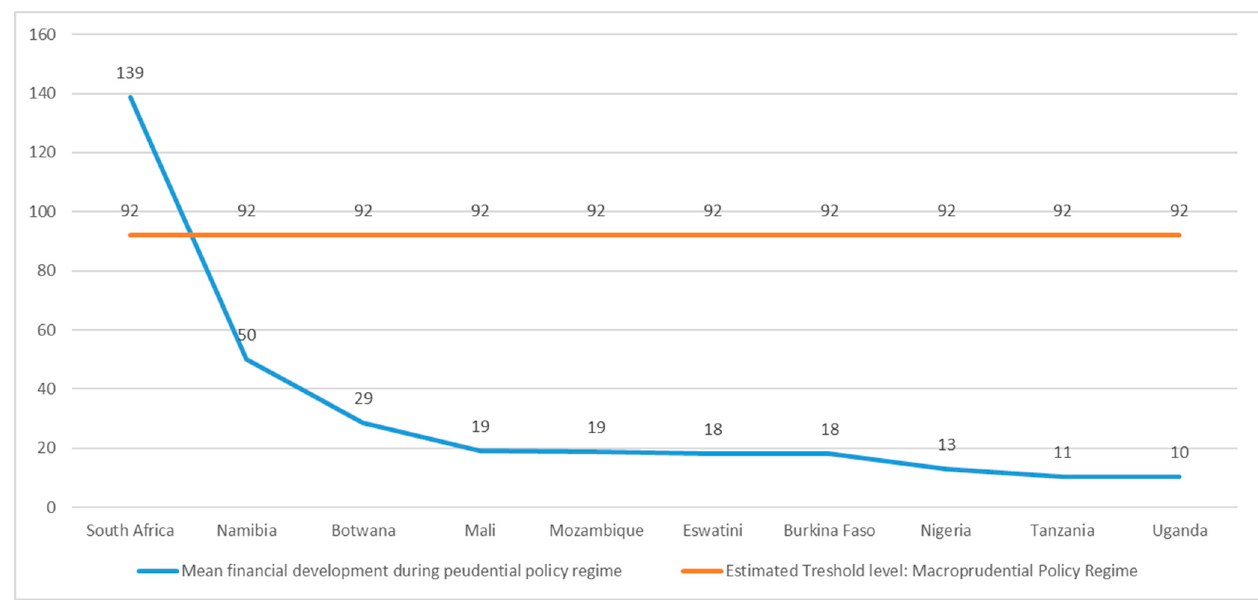
Figure 2. The mean GDPs per capita and the estimated thresholds. Source: Authors’ calculation based on WDI (2022) data.